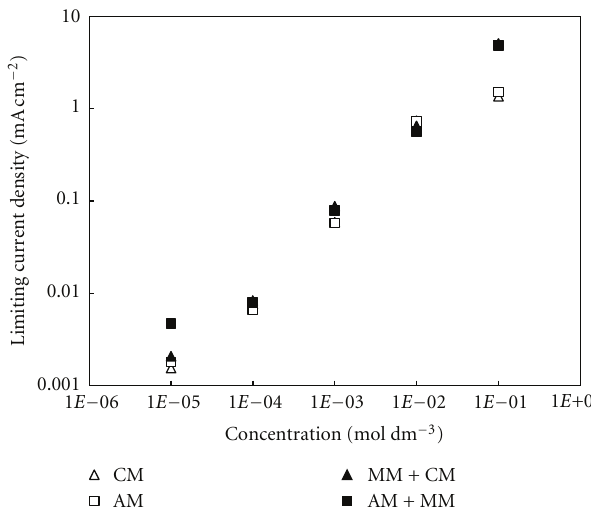
Figure 2: Limiting current density of 4 membrane arrangements in KCl solution. Symbols are inserted in the figure.